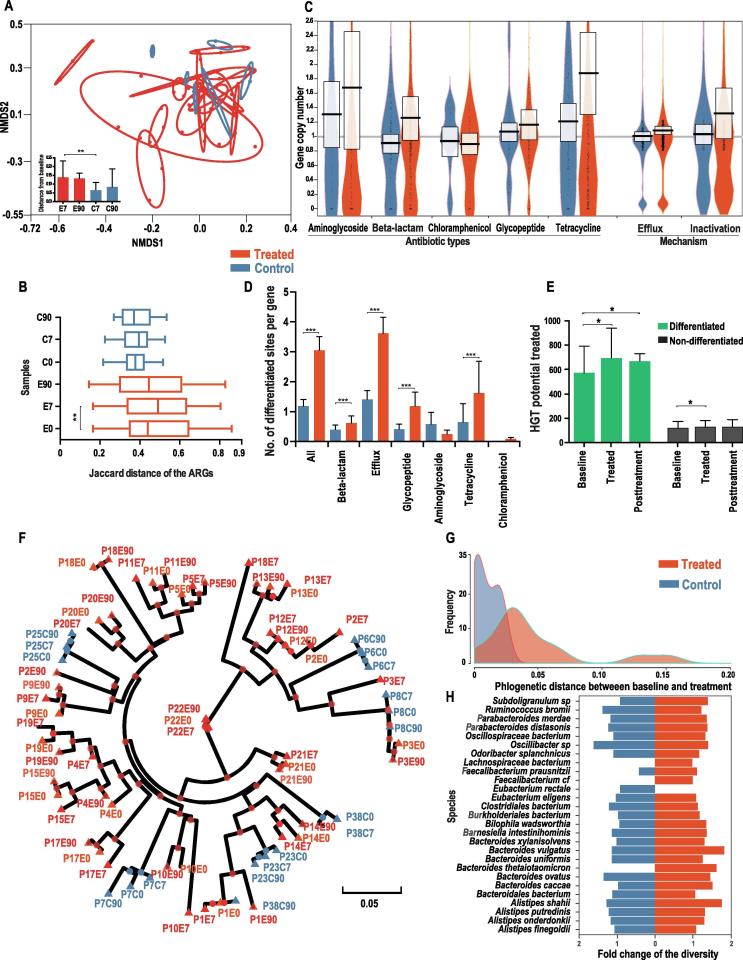
Divergence of the resistome and dominant strains in the prevalent species upon antibiotic intakeA. NMDS based on the Jaccard distance of antibiotic resistance gene profiles (presence/absence) (stress value <0.05). E7, E90, C7, C90 represent the samples from Day 7 treatment, Day 90 post-treatment, Day 7 control, Day 90 control samples, respectively. The red and blue ovals surround samples from the same antibiotic treated and control subjects, respectively. The radii of the ovals reflect the compositional distances between samples from the same individual. A larger radius suggests a more drastically diverged resistome profile. B. Distribution of the Jaccard distance of ARGs profile between individuals at the same time point. C. Fold-change of the ARG copy number of major categories of ARGs. The boxes describe the mean and the standard deviation. D. Distribution of the percentage of differentiated site in various ARG categories. E. Variation of the HGT potential over time for differentiated and non-differentiated ARGs, in treated subjects at baseline, treatment, and post-treatment timepoints. F. Phylogenomic tree based on the concatenated dominant strains sequences of 28 prevalent species. Green, red, and blue colors denote the baseline of the treated, other time points of the treated, and control samples, respectively. The samples were named using the rules of “P + individual ID + E/C (treated or control group) + time point (day 0, 7, and 90)”, e.g., “P3E7” refers to the sample from day 7 (under antibiotic treatment) from individual 3. The green color denotes the baseline of treated subject. G. Density distribution of the phylogenetic distance between baseline and treated samples in Figure 1F. A larger phylogenetic distance reveals a faster evolution under antibiotic pressure. H. Distribution of the fold-change of the genome-wide nucleotide diversity in 28 prevalent species during the treatment. *P < 0.05; **P < 0.01; ***P < 0.001.